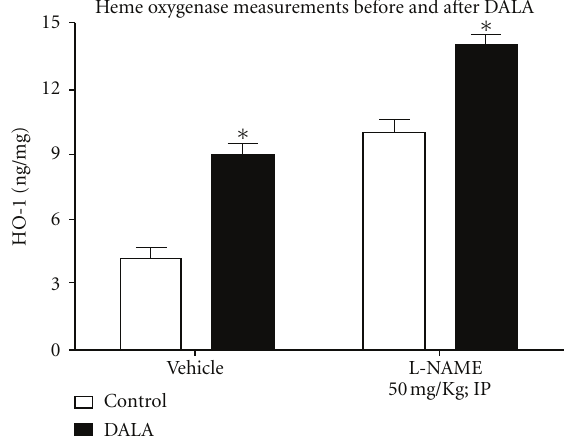
Figure 2: In anesthetized rats, DALA (80 μ mol/kg; IV) acutely increased renal HO-1 levels in vehicle (left) and L-NAME-treated (right) rats. ( ∗ P < 0 . 05, pre- versus 30min post-DALA; n = 6